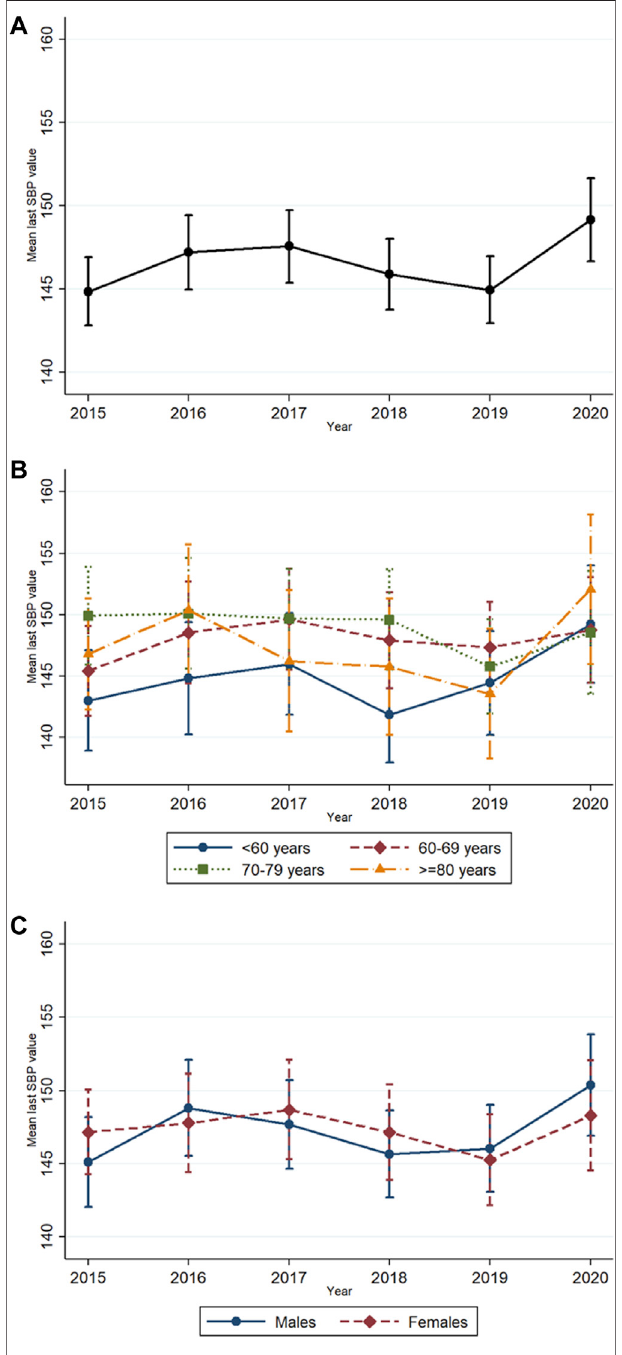
FIGURE 2 | Mean last systolic blood pressure (SBP) levels adjusted for all potential confounders with 95% con fi dence intervals before/at initiation of blood pressure-lowering medication from 2015 to 2020 in (A) the whole population, (B) different age groups, and (C) by sex.